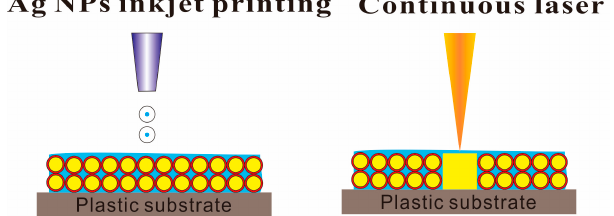
Figure 10. Selective laser sintering process of inkjet printed metallic NPs on a polymer substrate. The circles represent metallic NPs with protective agents and the square block indicates a conductor pattern of sintered metallic NPs. Unsintered NPs are simply washed away in an organic solvent. Int. J. Mol. Sci. 2019 , 20 , x 12 of 29